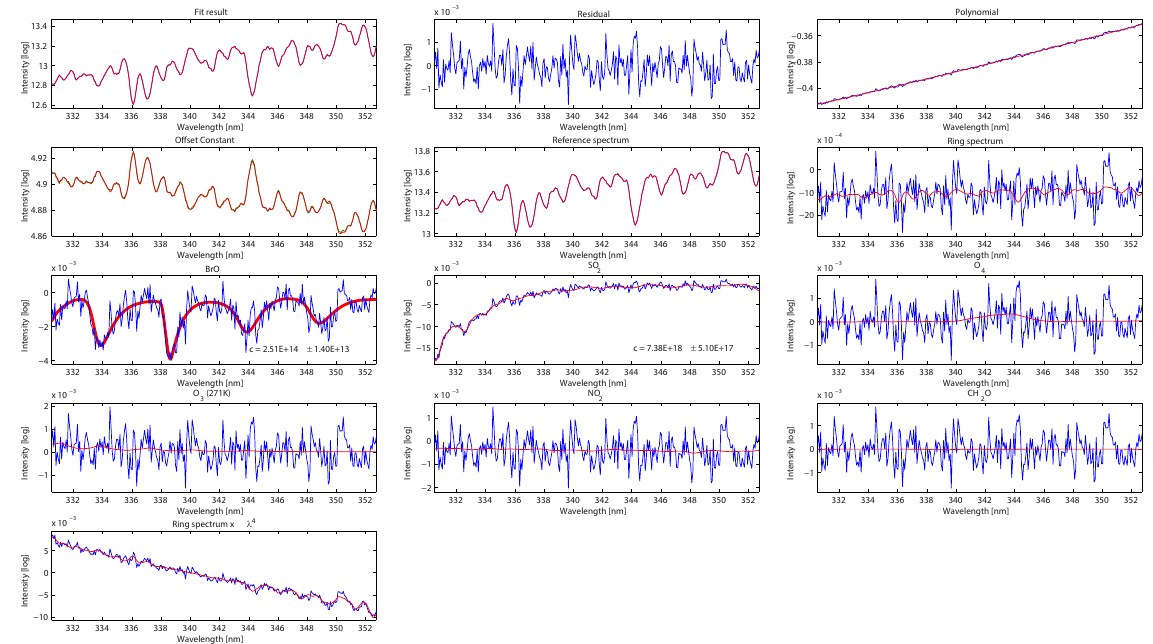
Figure 4. Example of a DOAS BrO evaluation performed in the wavelength range of 330.6–352.75 nm. The red lines show the fit, the blue lines the measurement data. A reference spectrum and two Ring spectra were included in the DOAS fit. The BrO column density is 2 . 51 × 10 14 moleculescm − 2 . Besides BrO, other trace gases (SO 2 , O 4 , O 3 , NO 2 , and CH 2 O) were included in the DOAS evaluation. The spectra recorded for this example were recorded on 31 October 2012 between 16:32 and 17:05GMT.